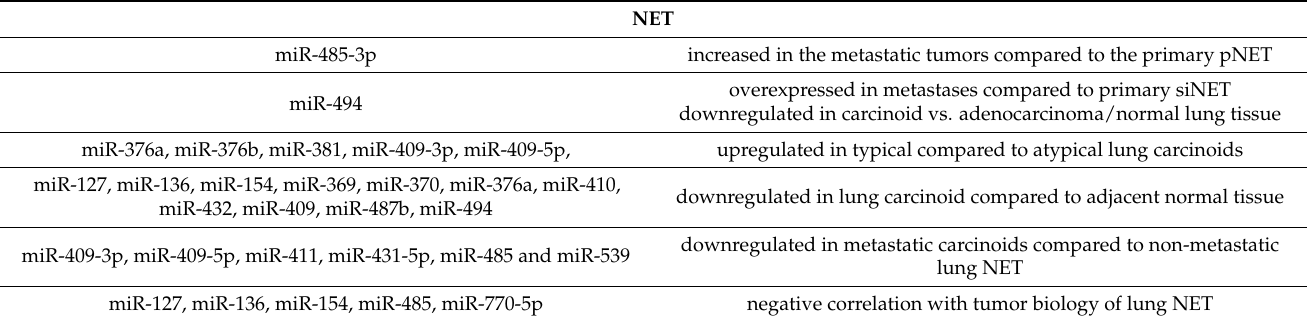
Table 2. Summary of the most important dysregulated, 14q32 encoded miRNAs in different endocrine neoplasms. NET increased in the metastatic tumors compared to the primary